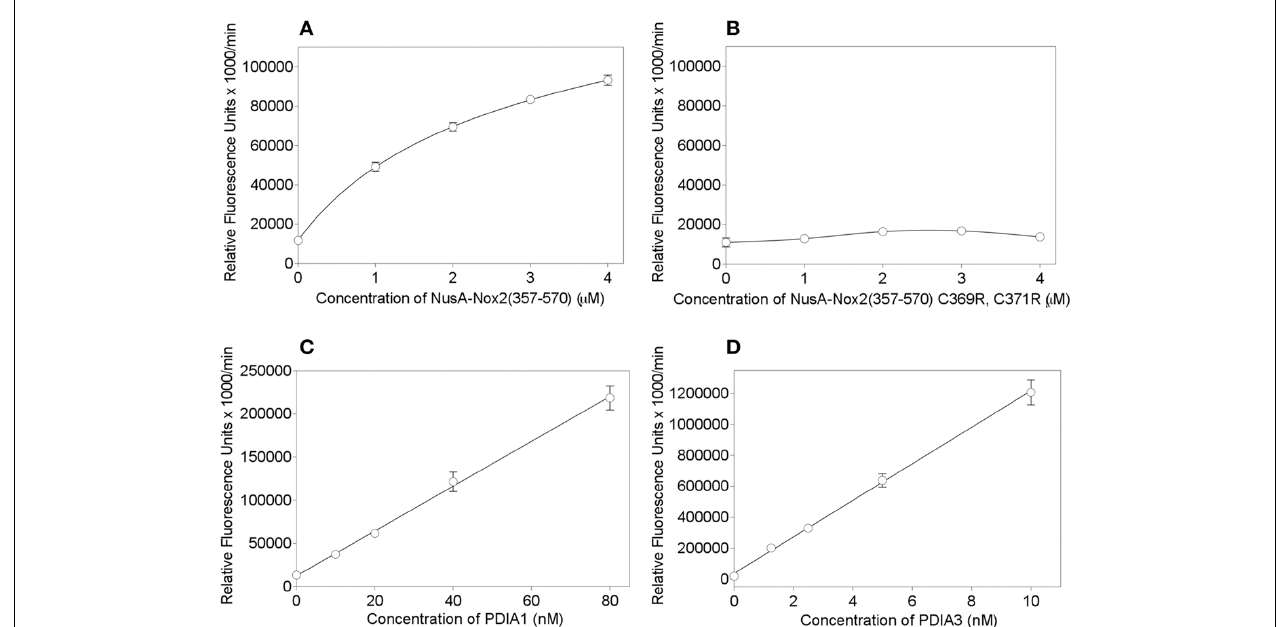
FIGURE 7 | PDI reductase activities of NusA-Nox2(357–570) compared to those of the NusA-Nox2(357-570) C369R, C371R mutant and to PDIA1 and PDIA3. (A) PDI reductase activity of recombinant NusA-Nox2(357–570) was assayed in a concentration range of 1–4 μ M and plotted as non-linear regression (one site binding equation). (B) PDI reductase activity of recombinant NusA-Nox2(357–570) C369R, C371R mutant was assayed in a concentration range of 1–4 μ M and plotted as a cubic spline curve. (C) PDI